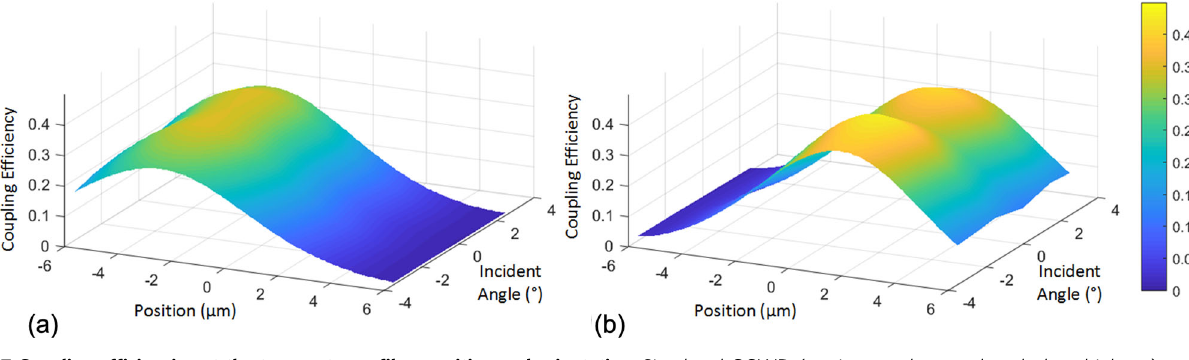
Fig. 7 Coupling ef fi ciencies at the two ports vs. fi ber position and orientation. Simulated GCWD (grating coupler wavelength demultiplexer) coupling ef fi ciencies at the two ports as functions of the input fi ber position and incidence angle. a Port 1 (1310 nm) and b Port 2